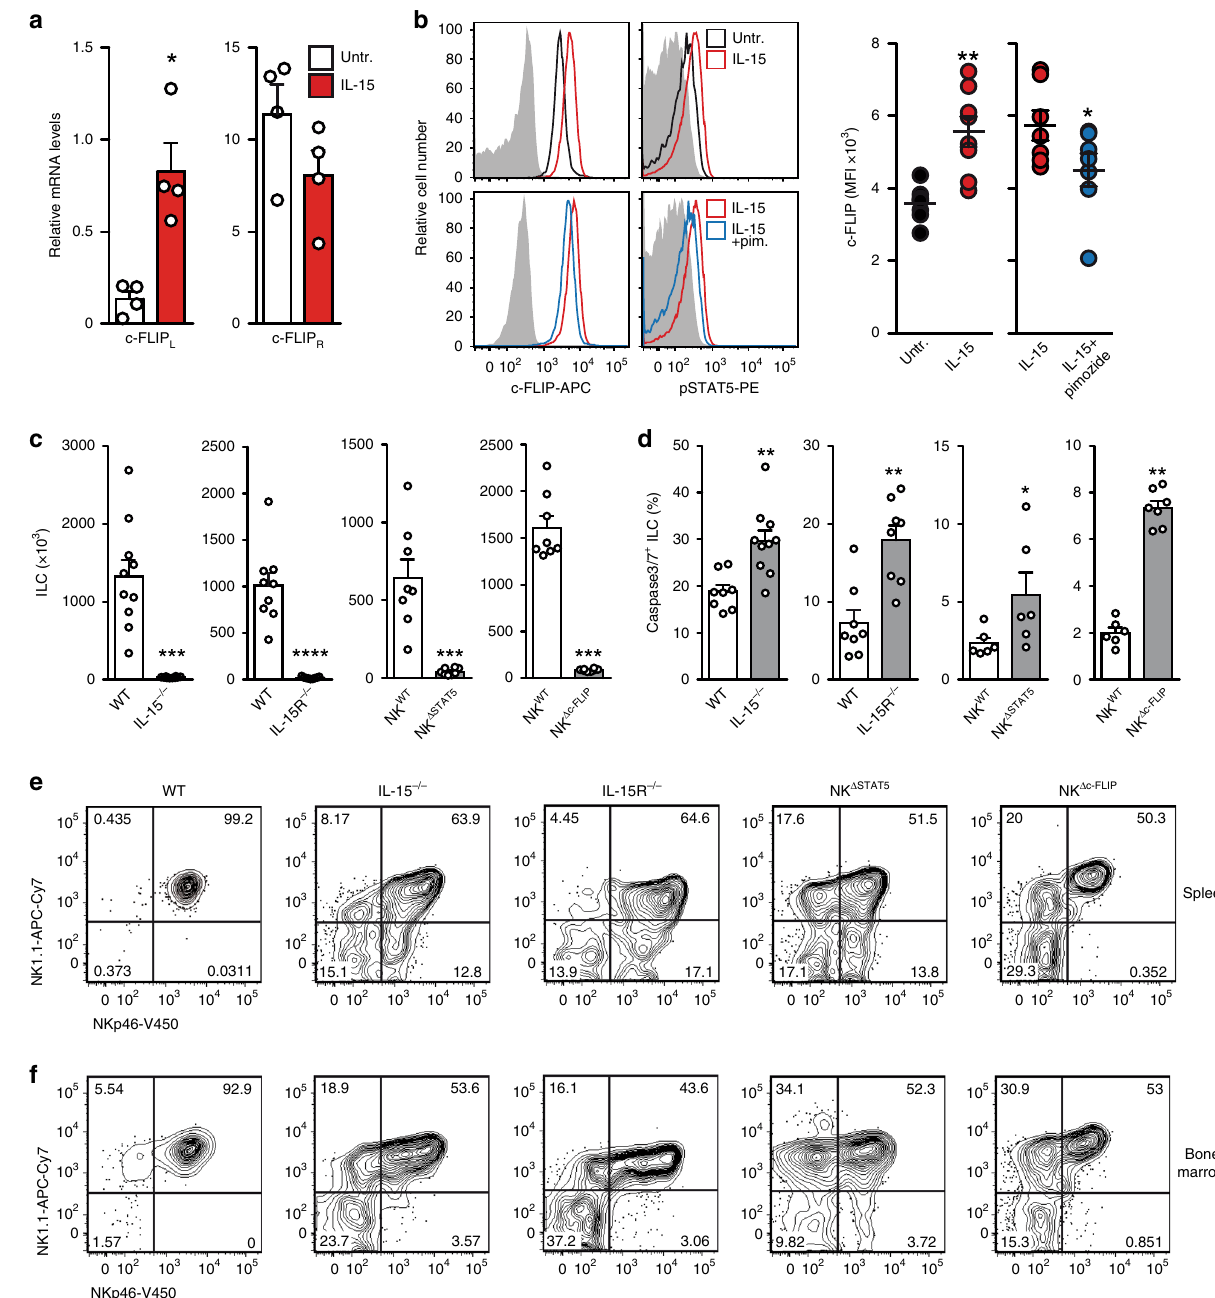
marrow30.9 Bone Fig. 1 c-FLIP is crucial for IL-15-dependent ILC development. a NK1.1 + NKp46 + ILC were FACS-puri fi ed from spleens of C57BL/6 (B6) wild type (WT) mice and incubated for 16 h w/wo IL-15. c-FLIP L and c-FLIP R mRNA levels were quanti fi ed by RT-qPCR. Data are from four independent experiments. b B6 splenocytes were cultured for 16 h in the presence (red) or absence of IL-15 (black; upper row). Alternatively, cells were cultured for 16 h in the presence of IL-15 with (blue) or without the STAT5 inhibitor pimozide (red; bottom row). Relative levels of c-FLIP and phosphorylated STAT5 (pSTAT5) were determined by fl ow cytometry. Shown are representative histograms ( fl uorescence minus one controls in gray) after gating on Lin − CD122 + NK1.1 + NKp46 + ILC. Graphs show mean fl uorescence intensities (MFI) from 2 – 3 independent experiments with a total of 7 – 8 mice per group. c – e Cells from spleen and f BM of the indicated mouse lines were analyzed by fl ow cytometry. c – f After gating on Lin − CD122 + cells, c absolute cell numbers ( n = 8 – 10) and d frequencies of active caspase3/7 + apoptotic NK1.1 + NKp46 + ILC were determined ( n = 6 – 10). e , f Shown are representative contour plots from at least two independent experiments with a total of e 8 – 10 or f 6 – 10 mice per group. Numbers indicate percentages. a – d Data represent mean + /± SEM. Source data are provided as source data fi le; * p ≤ 0.05; ** p ≤ 0.005; *** p ≤ 0.001; **** p ≤ 0.0001. a , c , d Two-tailed Mann – Whitney U test; b two-tailed Wilcoxon matched-pairs signed rank